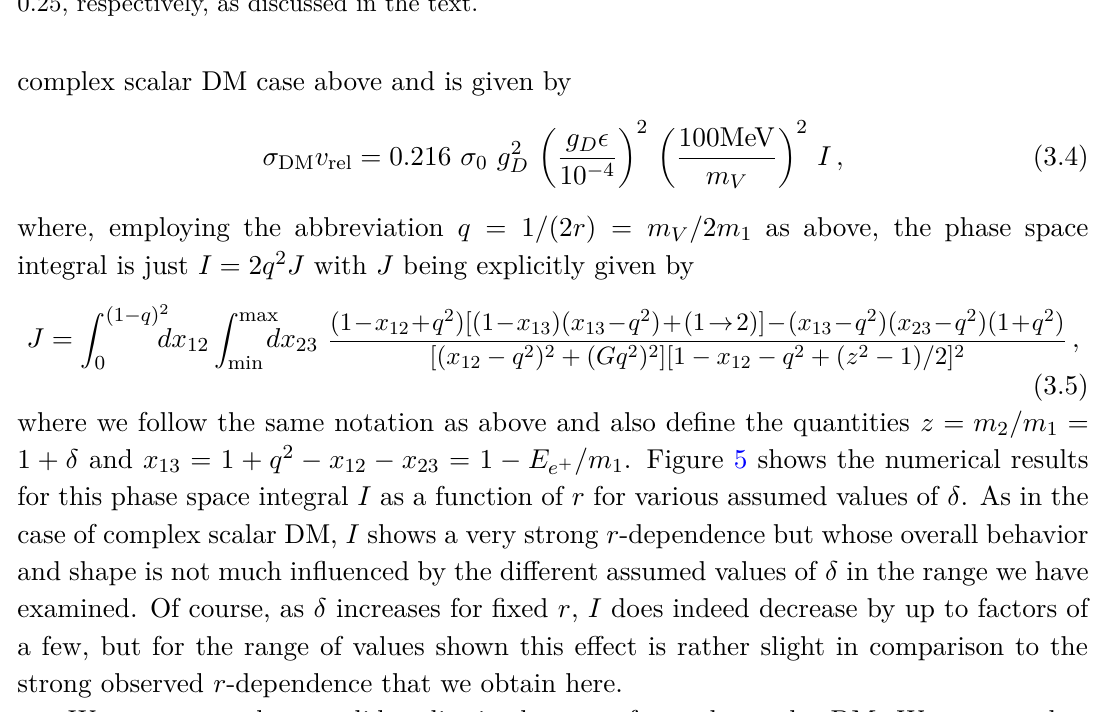
Figure 5 . The phase space integral I as defined in the text as a function of r for the case of psuedo- Dirac DM; from top to bottom the curves correspond to the choices of δ = 0 . 05 , 0 . 10 , 0 . 15 , 0 . 20 and 0 . 25 , respectively, as discussed in the